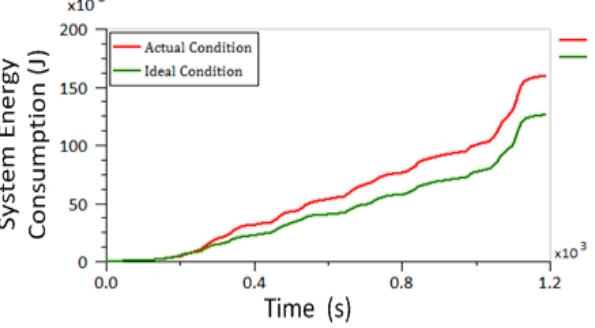
Figure 24. Radiator intake temperature rise caused by the coupling thermal transmission.